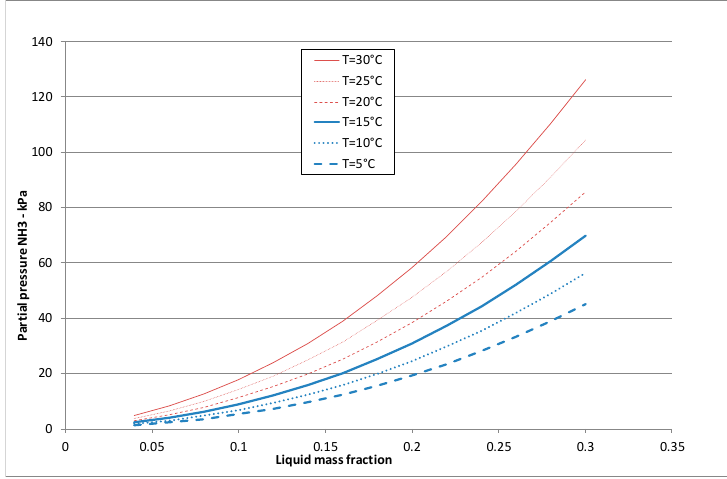
Figure 1. Evolution of the vapor pressure for ammonia as a function of temperature and pool concentration.